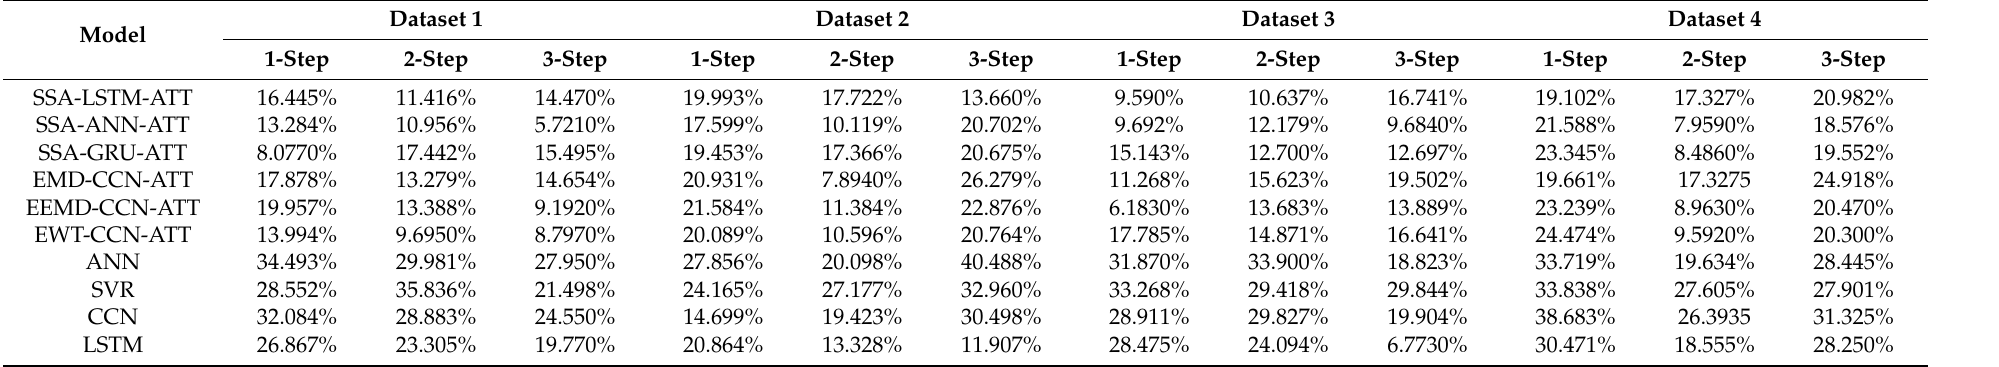
Table 9. Improvement ration of MAPE generated by the SSA-CCN-ATT from four